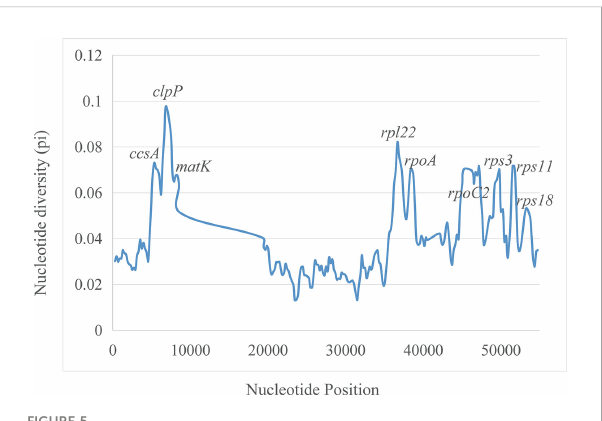
FIGURE 5 Sliding window analysis of nucleotide diversity (pi) along the twenty aligned plastomes of East Asian lobelias with one IR copy included. Genes underlying peaks of nucleotide diversity are labeled.